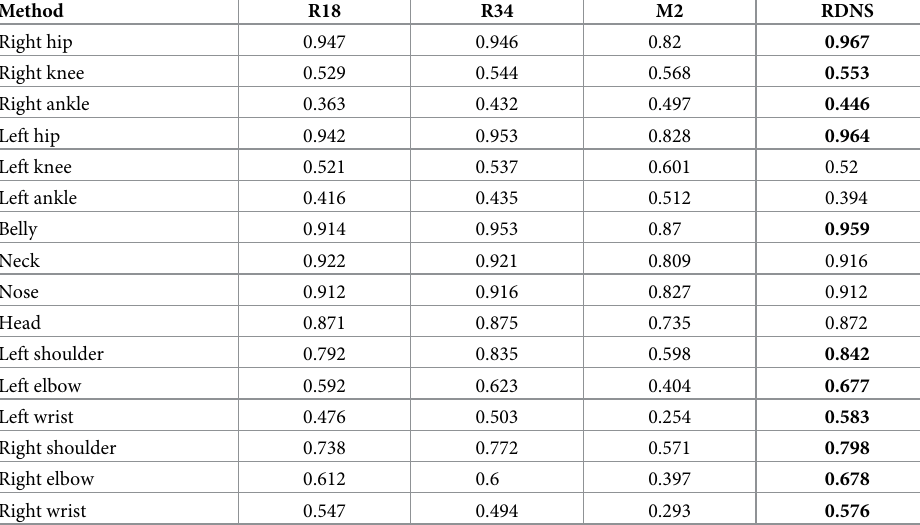
Table 2. The JDR results of each joint on the MPI-INF-3DHP dataset. The better results in our method are written in bold. R18 = Resnet-18, R34 = Resnet-34, M2 = Mobilenetv2.